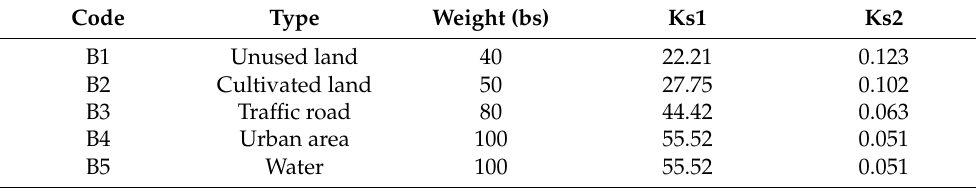
Table 4. Basic barrier types (Bs) in the Three Parallel Rivers Natural World Heritage Site.